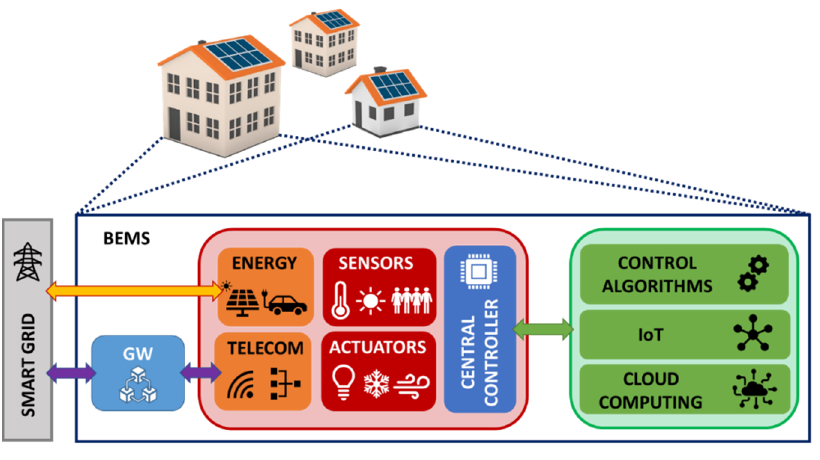
Figure 5. General architecture of a BEMS of a